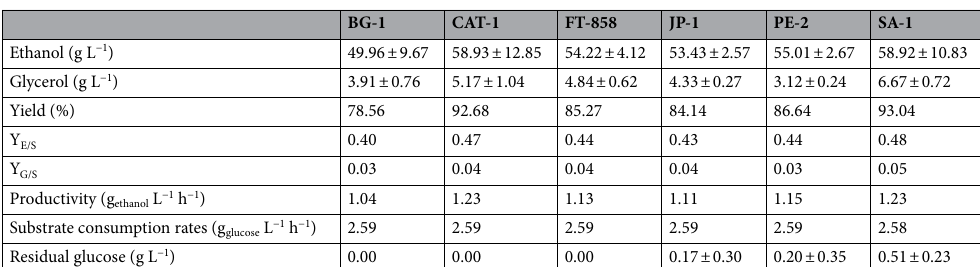
Table 1. BRS PAMPA rice fermentation parameters with different strains of Saccharomyces cerevisiae (N.B. standard deviation was determined from the essays carried out in